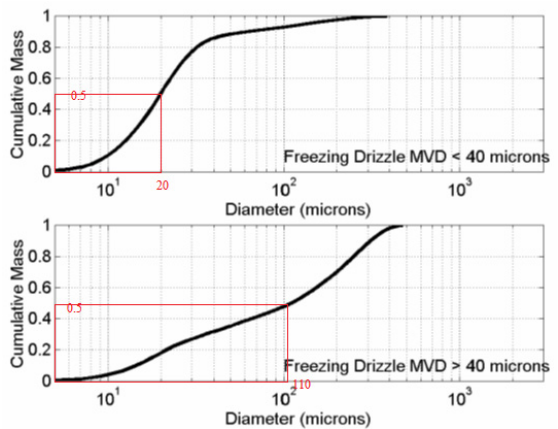
Figure 6. Appendix O—freezing drizzle, drop diameter distribution.